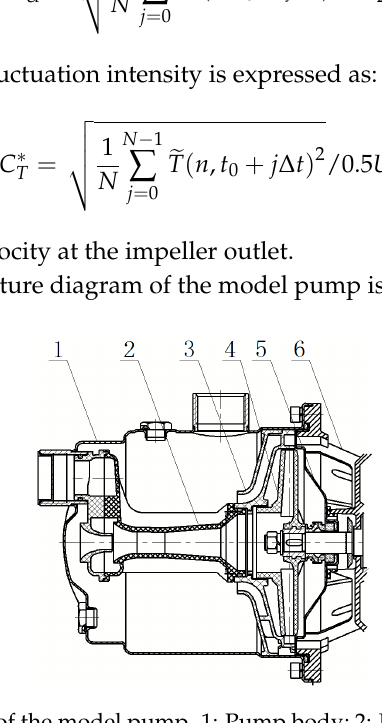
Figure 2. Structural diagram of the model pump. 1: Pump body; 2: Jet; 3: Guide vane; 4: Impeller; 5: Pump cover; 6: Bracket.